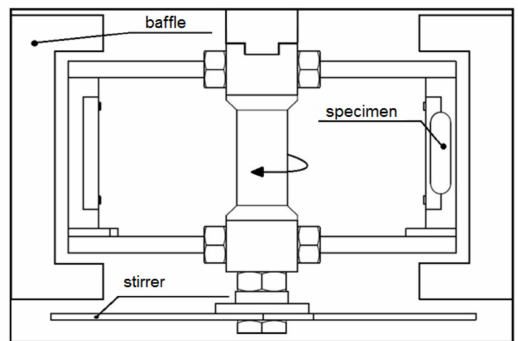
Figure 3. Scheme of a slurry pot tester.